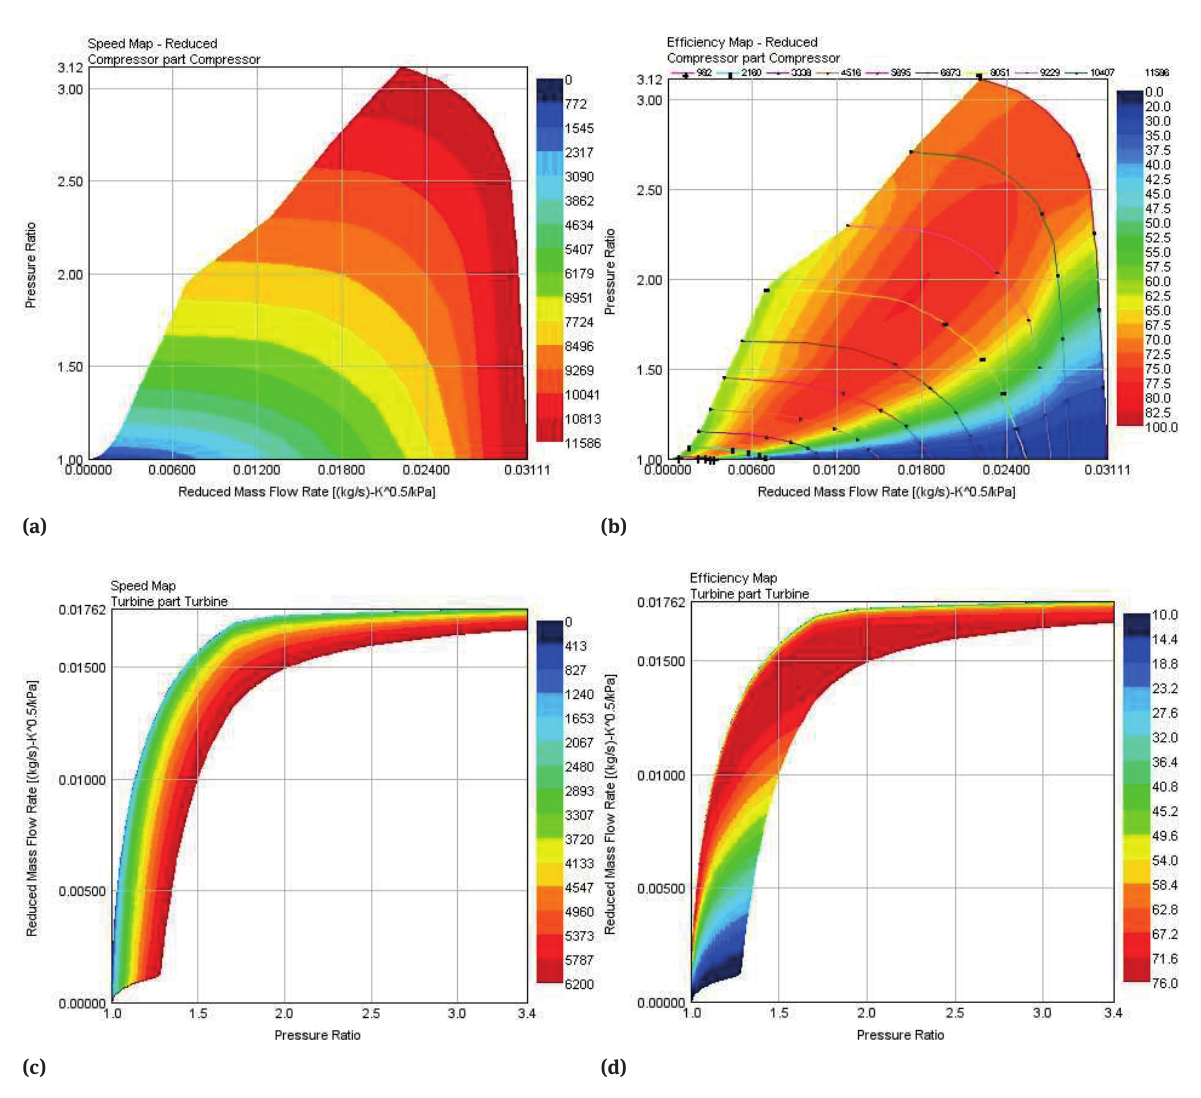
Fig. 4: Compressor and turbine maps: a) compressor reduced speed and b) compressor efficiency vs. pressure ratio and reduced mass flow rate. c) turbine reduced speed and d) turbine efficiency vs. pressure ratio and reduced mass flow